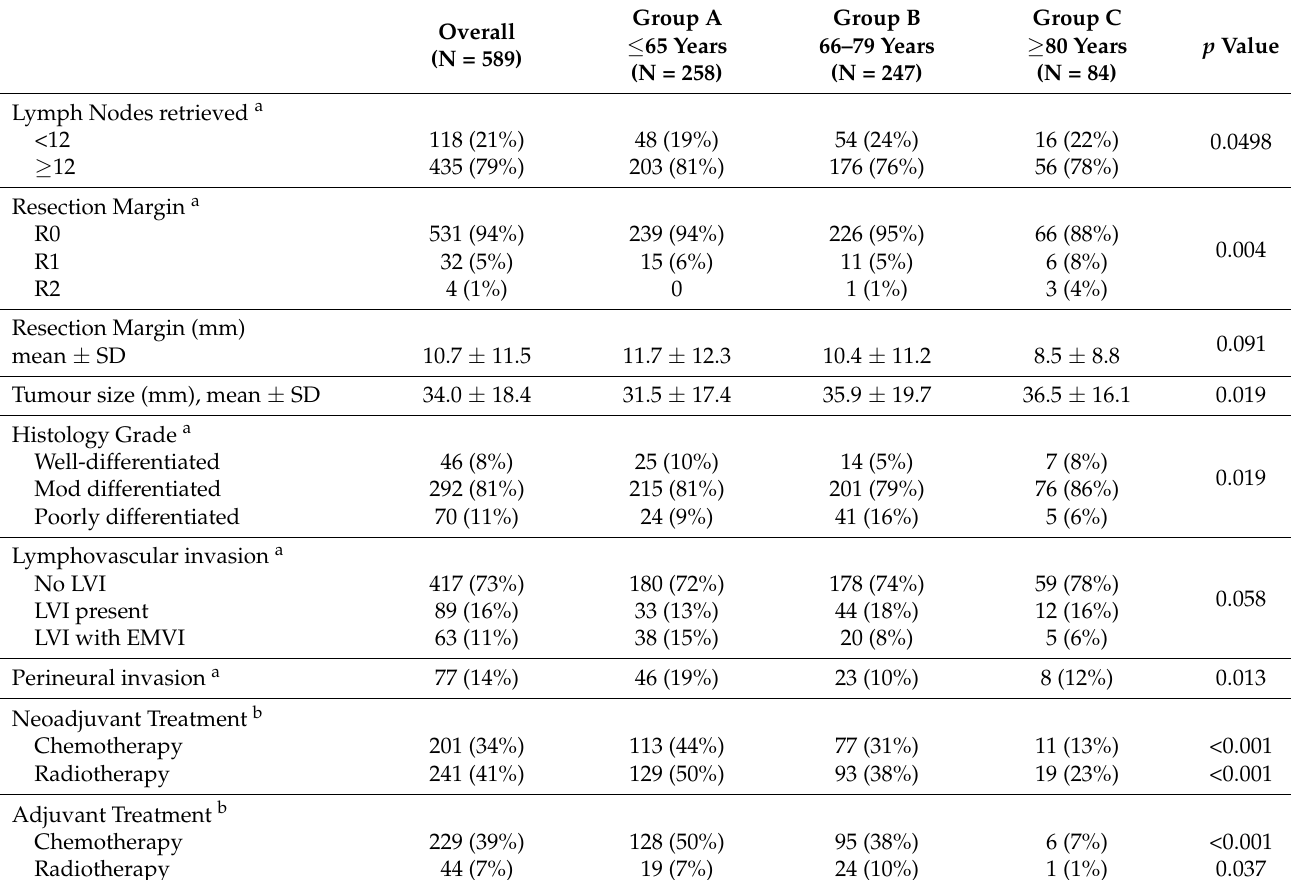
Table 3. Pathological differences and receipt of adjuvant/neoadjuvant therapy in rectal cancer patients that underwent surgery. Totals represent the total number of patients that underwent surgery in that age group.